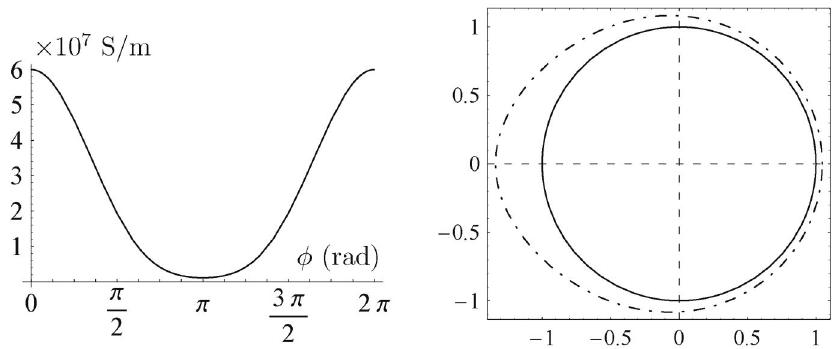
FIG. 1. Shape of the conductivity as a function of the azimuth (cid:19) (left plot) and corresponding behavior of the skin depth inside the conductor at 5 kHz (right plot). The conductivity varies from copper at room temperature ( (cid:19) (cid:1) 0 ) to stainless steel ( (cid:19) (cid:1) (cid:14) ). In the right plot, the black line represents the circular section of the pipe (in units of the radius) and the dash-dotted line is " (cid:2) (cid:19) (cid:4) =b away from (cid:1) 6 (cid:6) 10 7 S = m , (cid:5) (cid:1) 10 6 S = m it, where b is the pipe radius. ( b (cid:1) 2 cm , (cid:5) Cu Ss